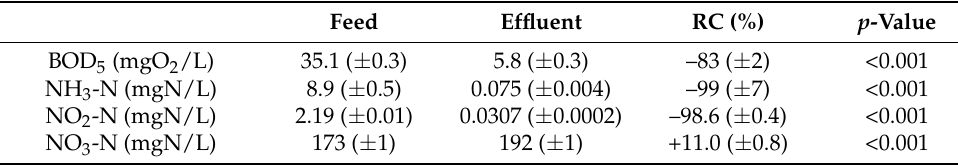
Table 3. Vermifiltration treatment feed, effluent, and relative change (RC) in water quality parameters. The results are presented as triplicate ( n = 3) mean ± standard